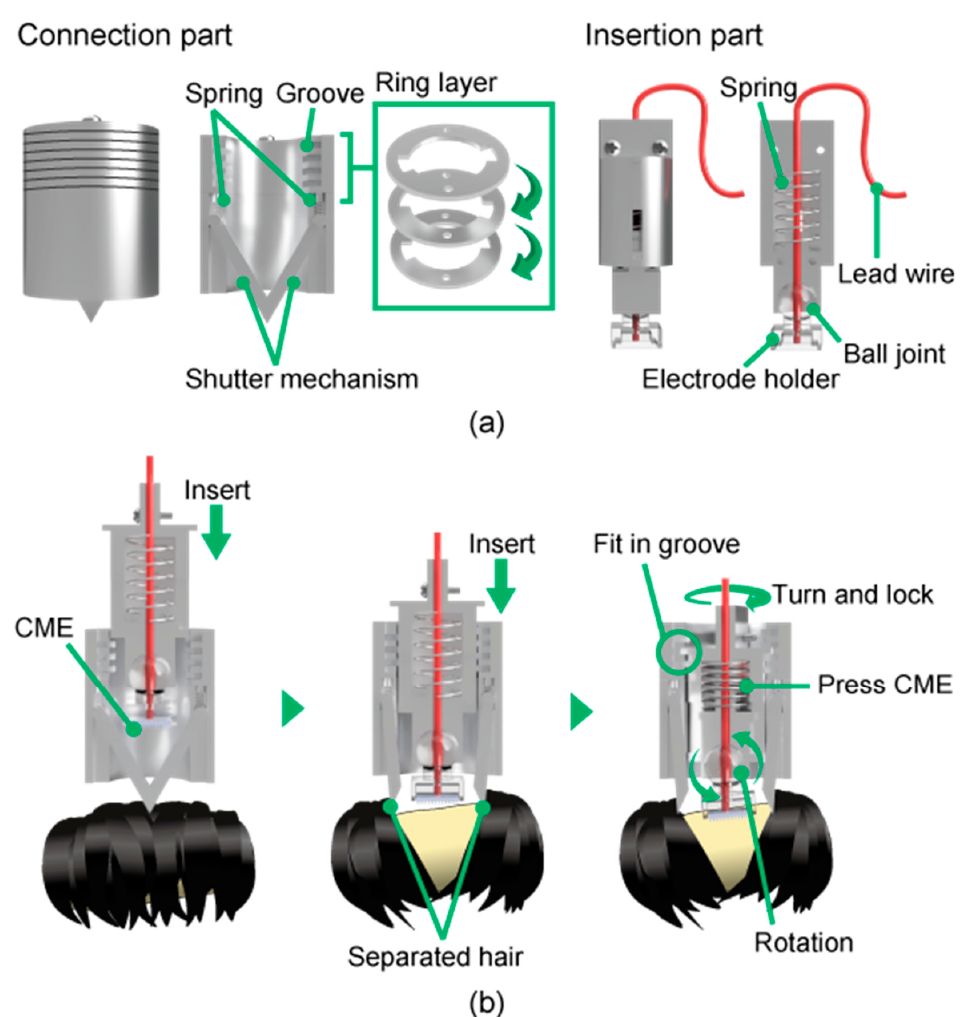
Figure 4. ( a ) Detailed design of the module. The shutter mechanism is housed in the connection part. CMEs are mounted in the insertion part and connected to a polygraph via the lead wire. ( b ) The overall function of the module. Hair is mechanically separated by the shutter mechanism. The contact